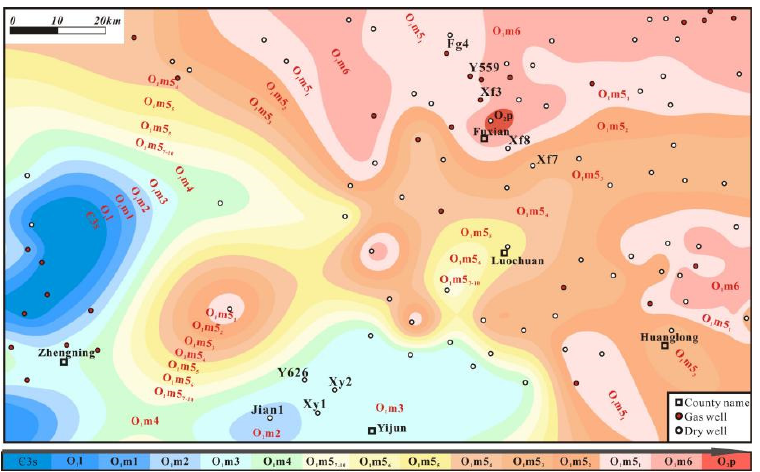
Figure 10. Pre-Carboniferous paleogeological map of the southeastern Ordos Basin. Є 3 s is the upper Cambrian Sanshanzi Fm.; O 1 l is the Lower Ordovician Liangjiashan Fm.; O 1 m is the Lower Ordovician Majiagou Fm.; O 1 m 1, O 1 m 2 … O 1 m 6 represent the six members of the Majiagou Formation from lower to upper; O 1 m 5 1 , O 1 m 5 2 , … O 1 m 5 10 represent the submembers of the O 1 m 5 member from upper to lower.